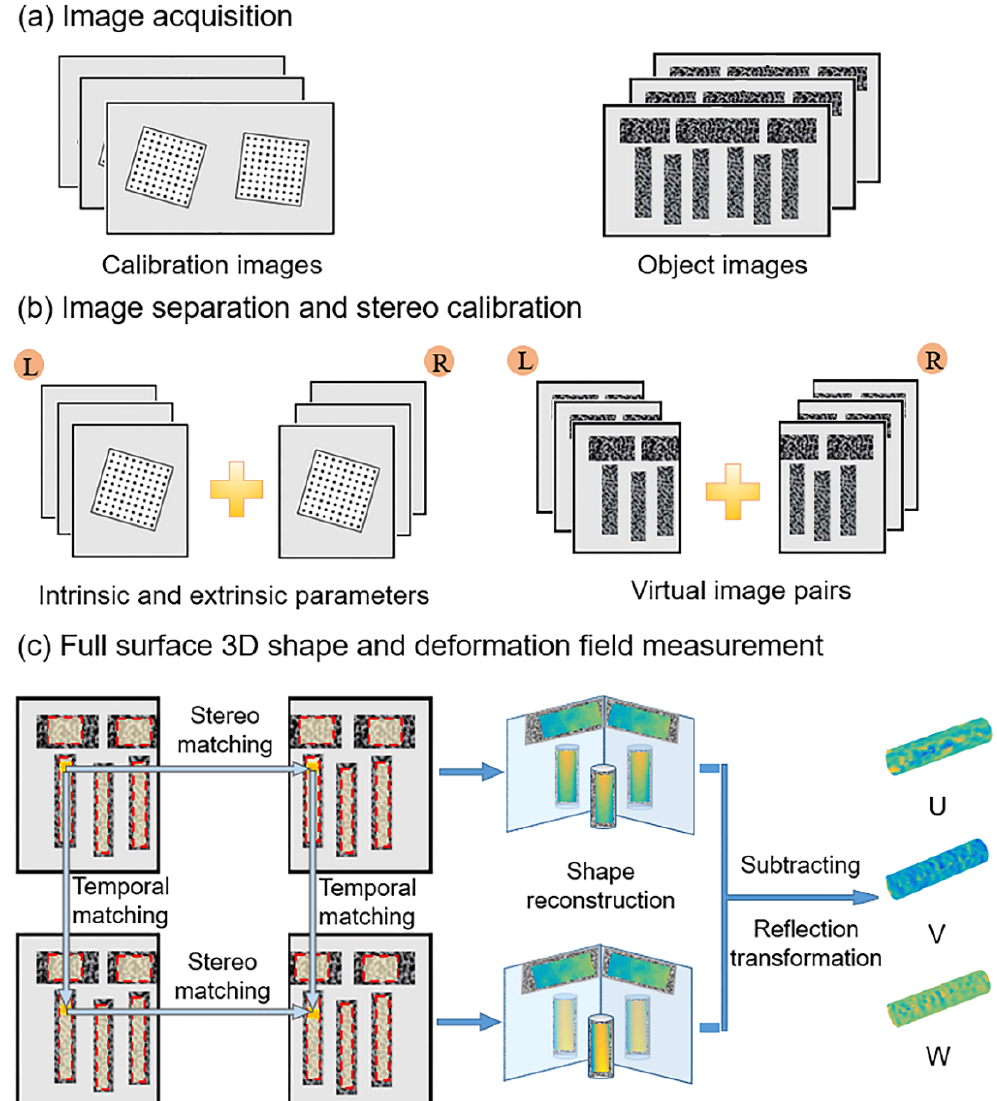
Figure 3. Implementation procedures of the proposed single-camera panoramic digital image correlation measurement.